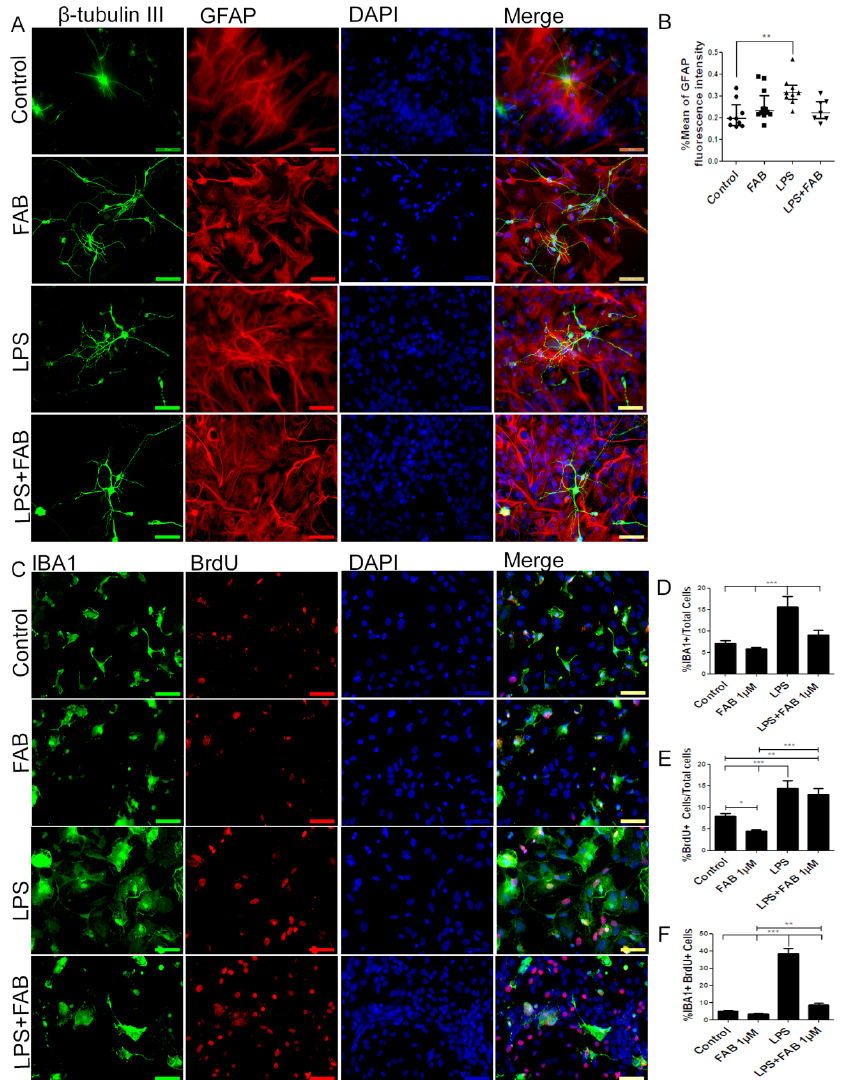
Figure 2. Agathisflavone preserves neuronal morphology and decreases microgliosis . ( A ) Representative photomicrographs of immunolabeling for the neuronal marker β -TubIII (green) and astrocyte marker glial fibrillary acidic protein (GFAP) (red); nuclei were counterstained with DAPI (blue); scale bar: 50 µm. Representative images were chosen from the field that better represented astrocyte–neuron proximity. ( B ) Boxplot graph showing GFAP immunofluorescent intensity (% mean); values are expressed as the median and were tested for significance using the Kruskal–Wallis test followed by Dunn’s test. ( C ) Analysis of cell proliferation by bromodeoxyuridine (BrdU) (red) incorporation into the DNA of microglia cells (Iba-1, green) exposed to 1 µM of FAB or in control conditions (0.1% DMSO) 24 h after treatment. Cell nuclei were stained with DAPI (blue). Scale bar: 50 µm. ( D – F ) Bar graphs showing the total number of Iba-1 + cells, total BrdU + cells, and BrdU + /Iba-1 + cells (microglial proliferation) expressed as a percentage of the total number of cells counted; values are expressed as the mean ± SEM ( n = 3) and were tested for significance by one-way ANOVA. ** p < 0.01 and *** p <